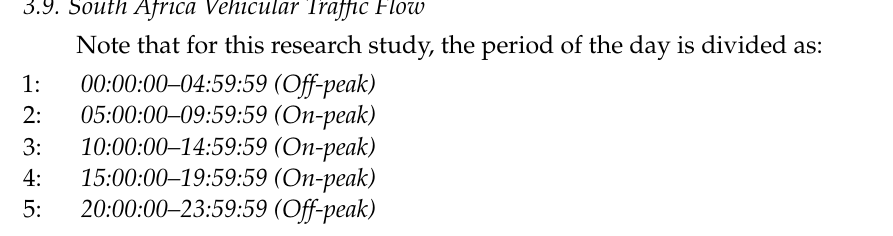
Figure 6. Video cameras attached to a traffic signal light.